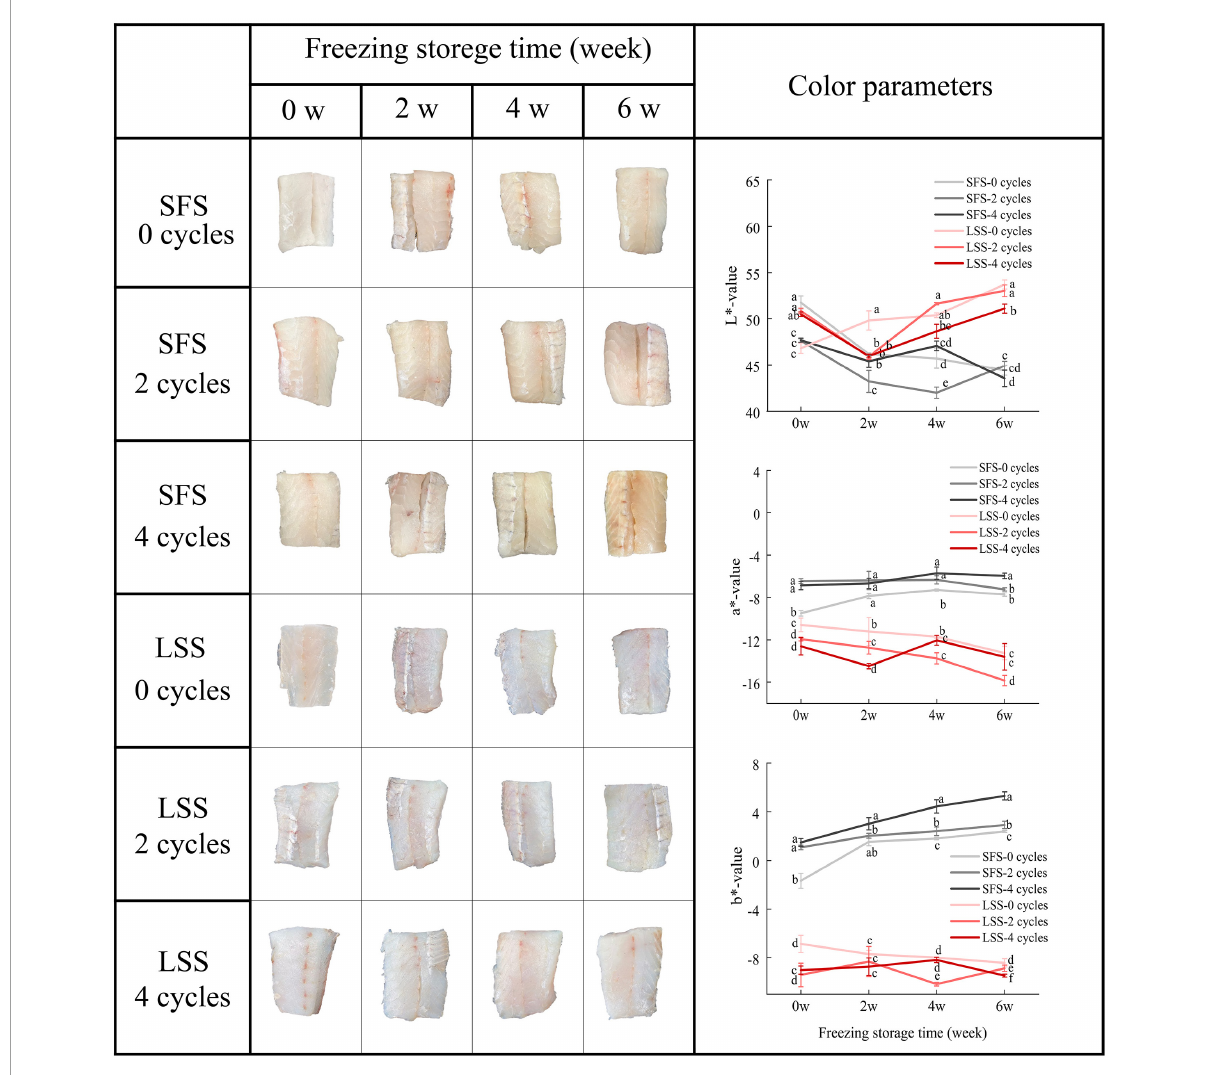
FIGURE4 Changes in color of LYC during frozen storage. SFS and LSS represent the salt-free soaking group and low-salt soaking group, respectively. Different letters in the figure present significant differences between the six samples ( P <